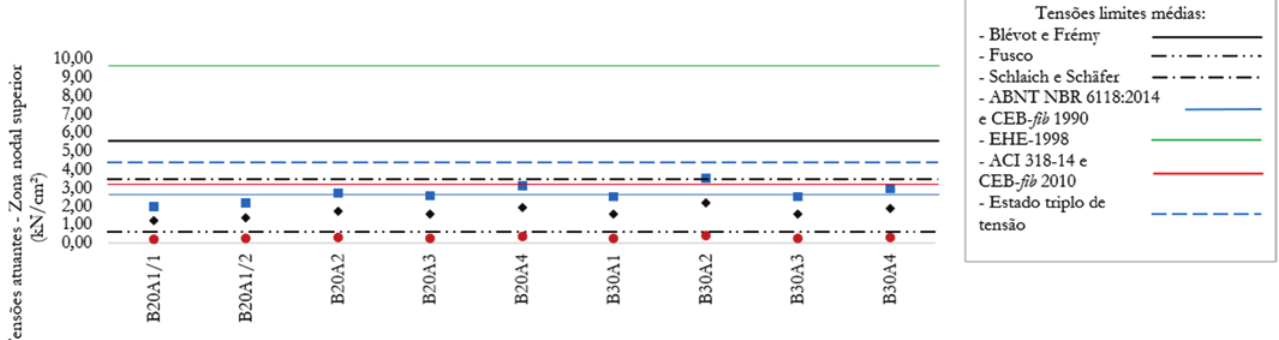
Modelos ensaiados por Miguel [8] × σ